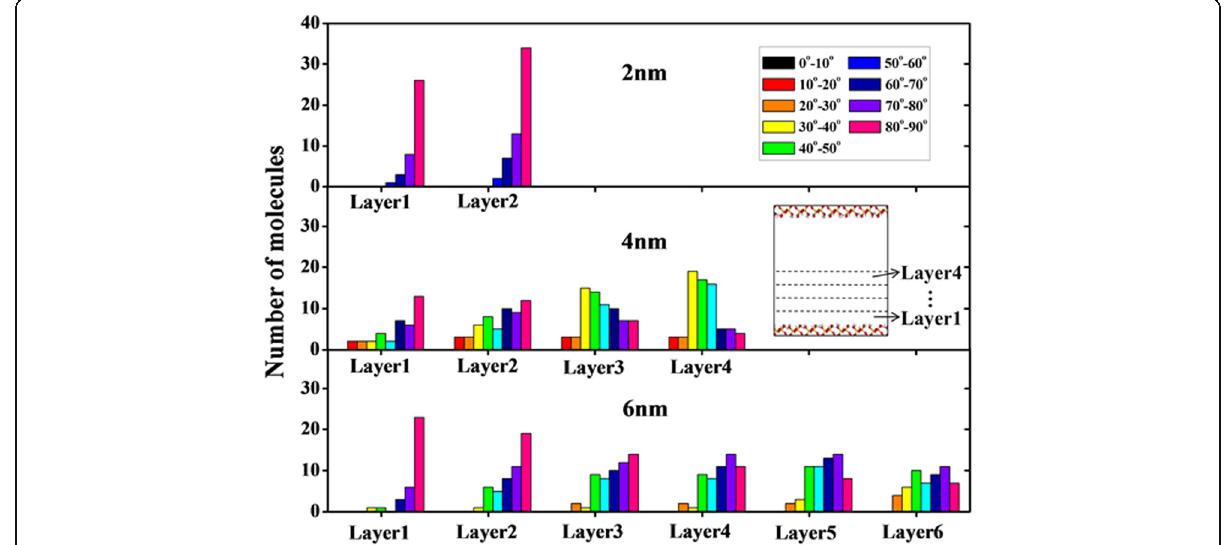
Fig. 4 The orientation angle distribution of octadecane molecules in each layer for different channel